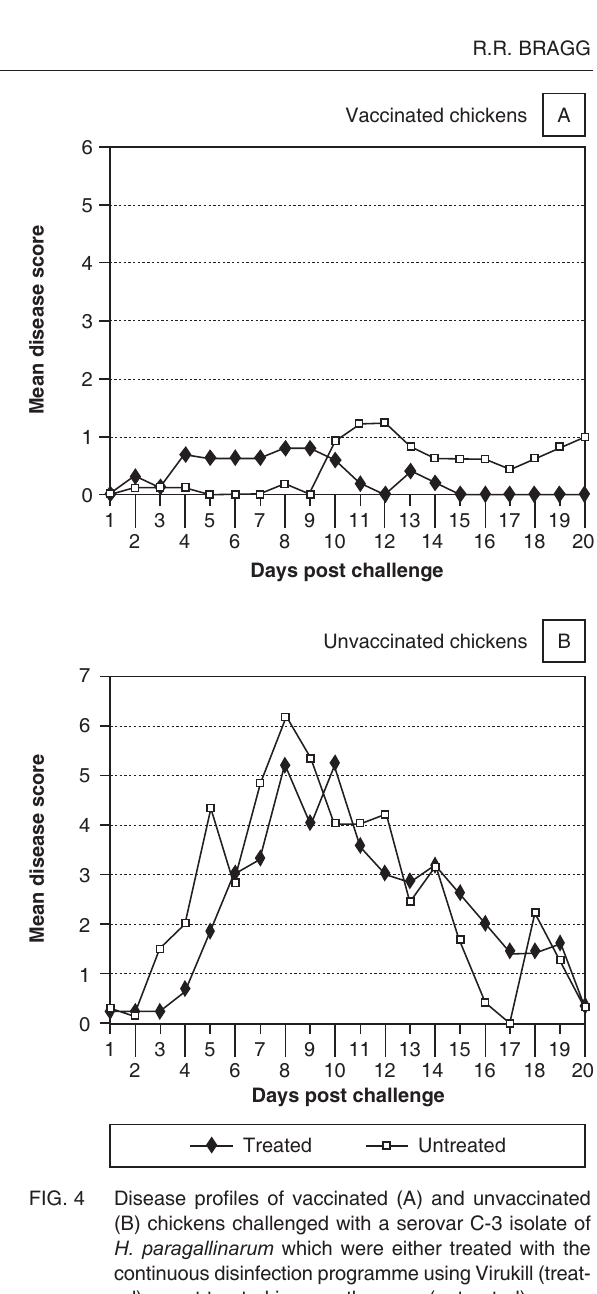
FIG. 4 Disease profiles of vaccinated (A) and unvaccinated (B) chickens challenged with a serovar C-3 isolate of H. paragallinarum which were either treated with